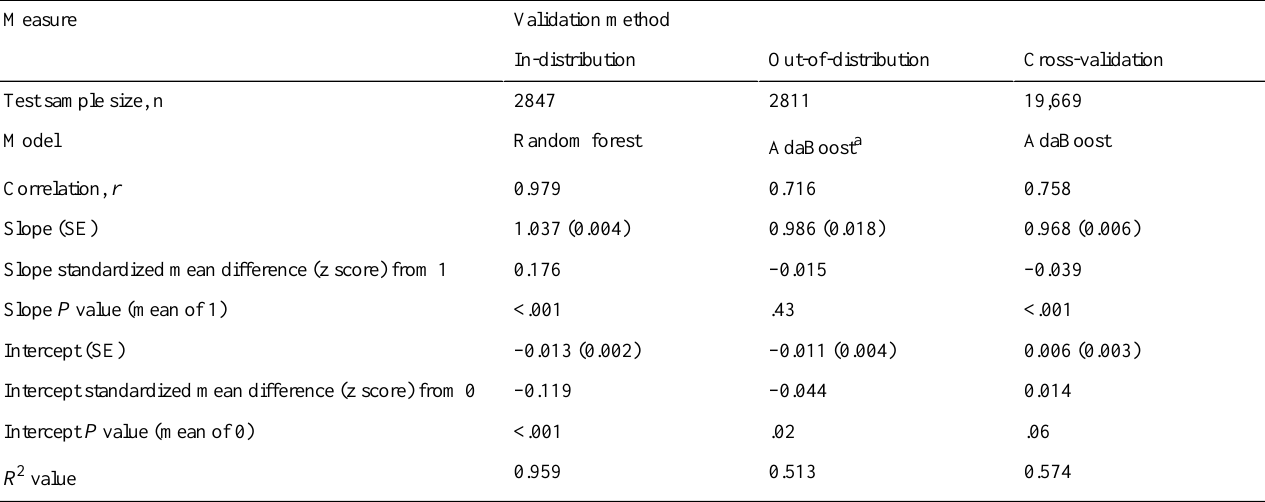
median percent errors also increase with label bins greater than Table 11). For all validation methods, the mean MAE and Table 8. Linear calibration measures of the models with the lowest test mean absolute error for each validation method.